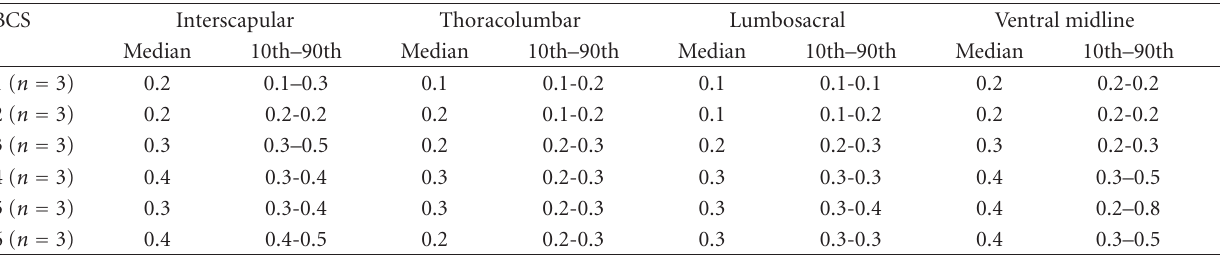
Table 3: Medians and 10th to 90th percentiles (in cm) for dissected physical fat depth measurements by site and body condition score category (BCS 1–6) (total n =